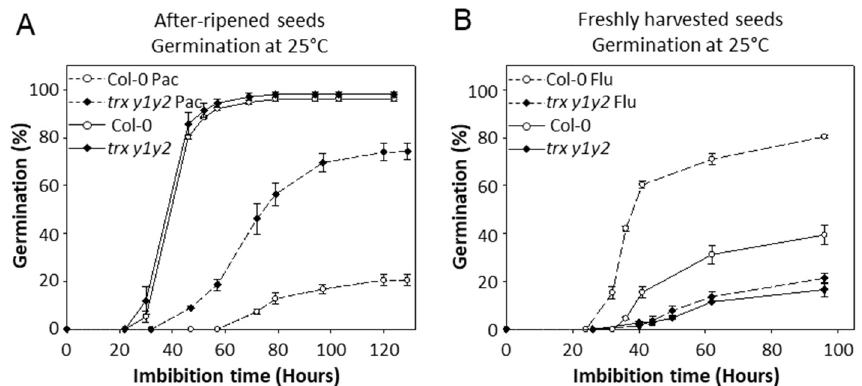
Figure 5. Germination of WT and trx y1y2 mutant seeds in the presence of hormone synthesis inhibitors. ( A ) After-ripened seeds were germinated in the light with addition of paclobutrazol (biosynthesis inhibitor of GAs) (Pac, 5 µ M). ( B ) Freshly harvested seeds were germinated in the dark with addition of fluridone (biosynthesis inhibitor of ABA) (Flu, 25 µ M). Triplicates were averaged. Bars indicate SD of the mean.